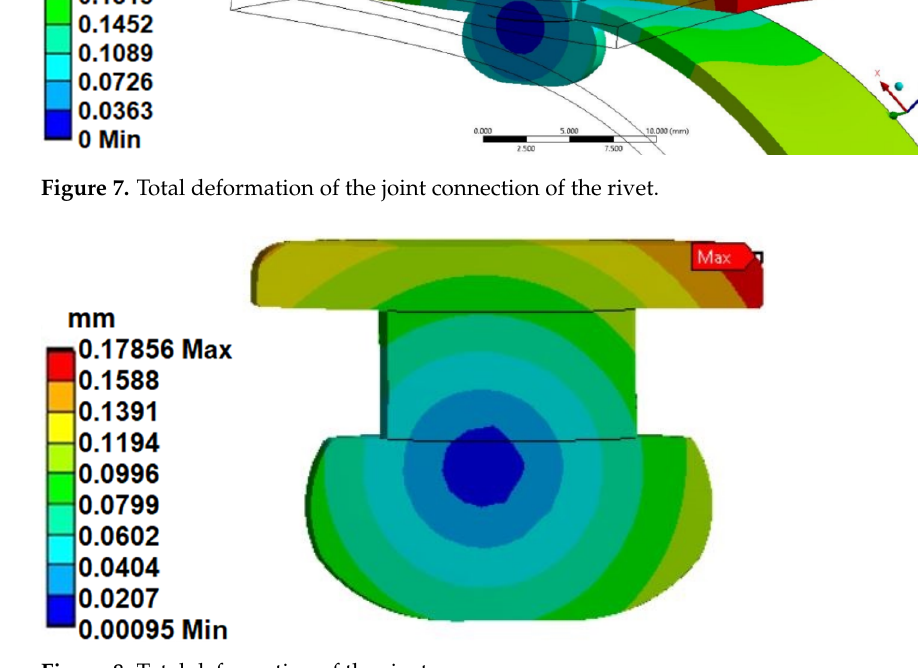
Figure 8. Total deformation of the rivet.